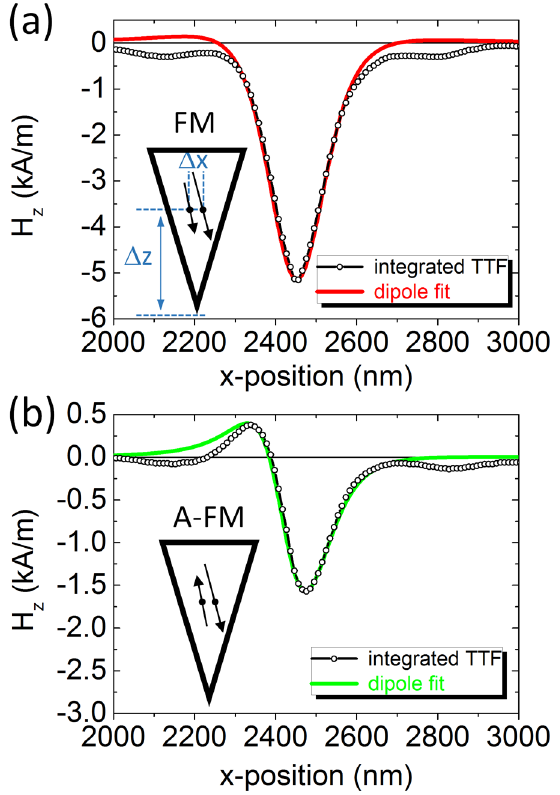
Figure 4. Stray field profiles obtained from integrated RSTTF. Stray field profiles for the thin ML-MFM probe in the ( a ) FM and ( b ) A-FM states, obtained 55 nm below the probe apex. Δ x and Δ z are horizontal and vertical displacement of the two dipoles, respectively. The profiles are fitted with the two-layer point dipole parameters listed in Table 1. MFM Probe State